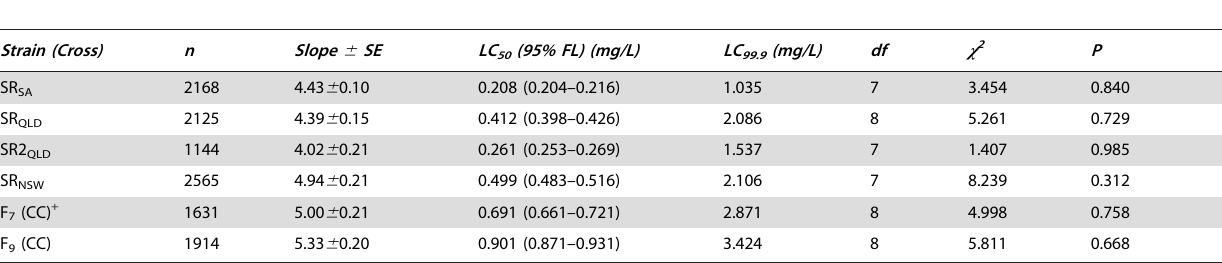
Table 1. Probit analysis of the response to phosphine exposure of four strongly resistant R. dominica strains, SR QLD , SR2 QLD SR NSW , SR SA , as well as their combined cross progenies.